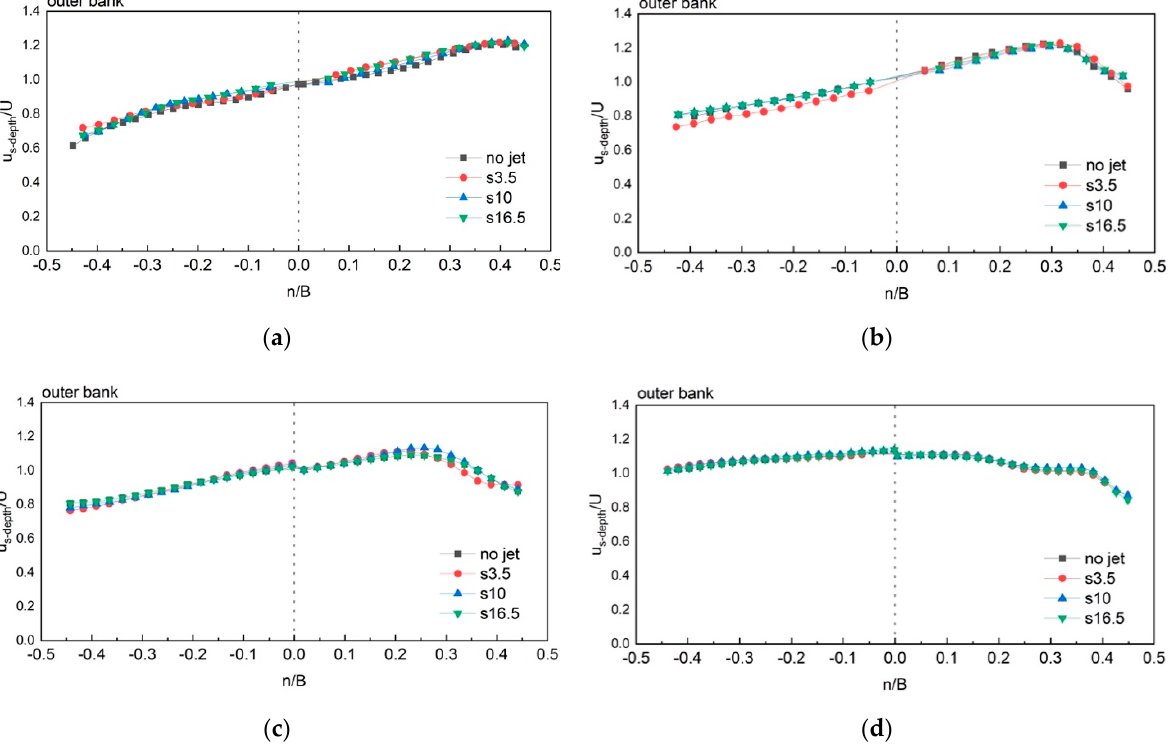
Figure 6. Dimensionless depth-averaged streamwise velocity across each sectional plane, with different jet conditions: ( a ) 37-degree plane; ( b ) 90-degree plane; ( c ) 105-degree plane; ( d ) 125-degree plane.